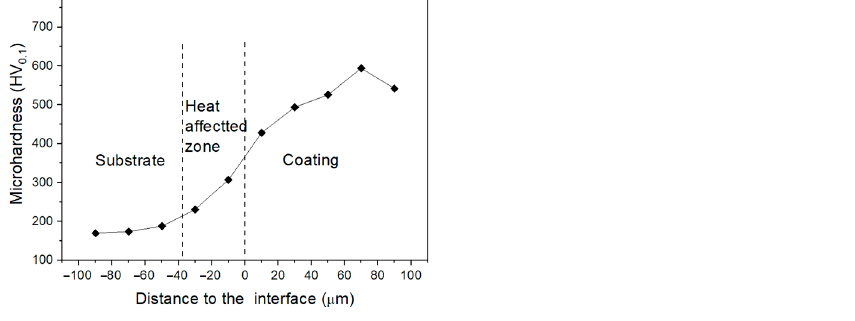
Figure 4. Micro-hardness values on the cross-section of the sample from the substrate to the coating.